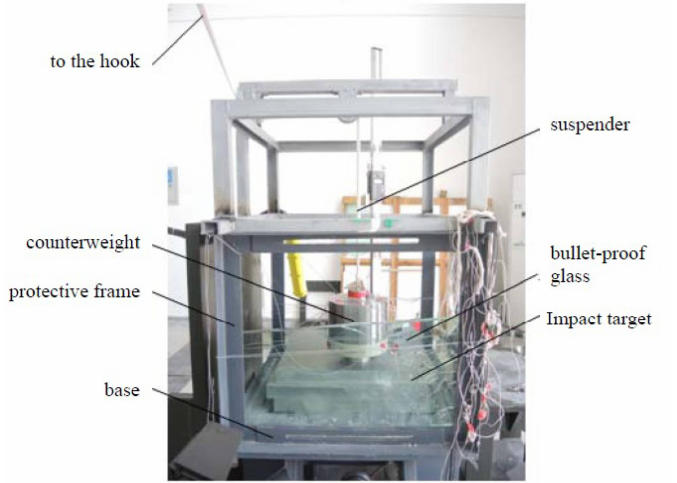
Figure 5. Dropping test